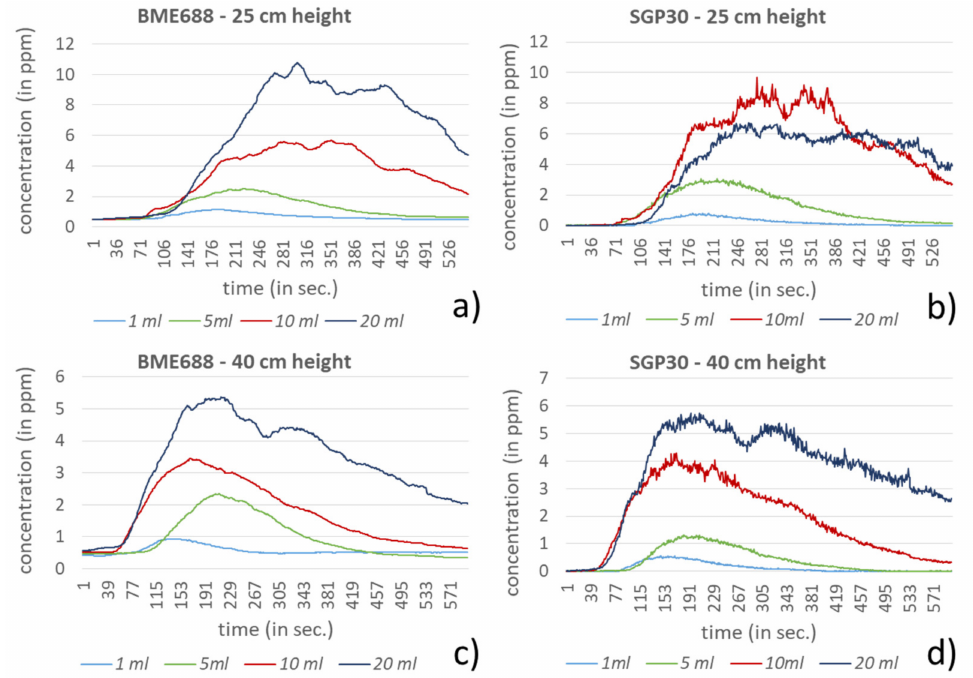
Figure 12. Response of BME688 and SGP30 for different amounts of hexane and for 25 and 40 cm height above the emission source. In ( a ) a measurement height of 25 cm for BME688 and ( b ) for SGP30 is used. In ( c ) the measurement height was changed to 40 cm for BME688 and ( d ) for SGP30.